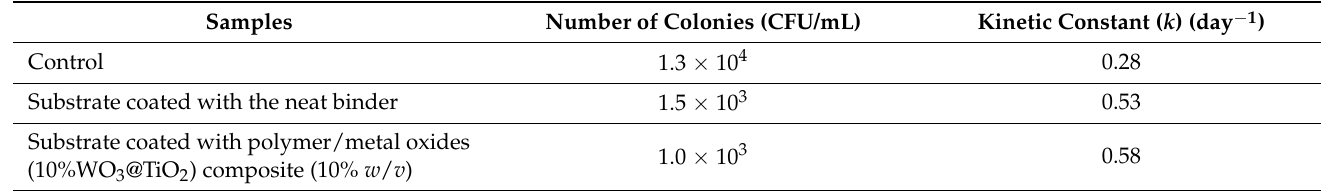
Table 3. Number of colonies and kinetic constants of samples treated by seawater for 7 days.